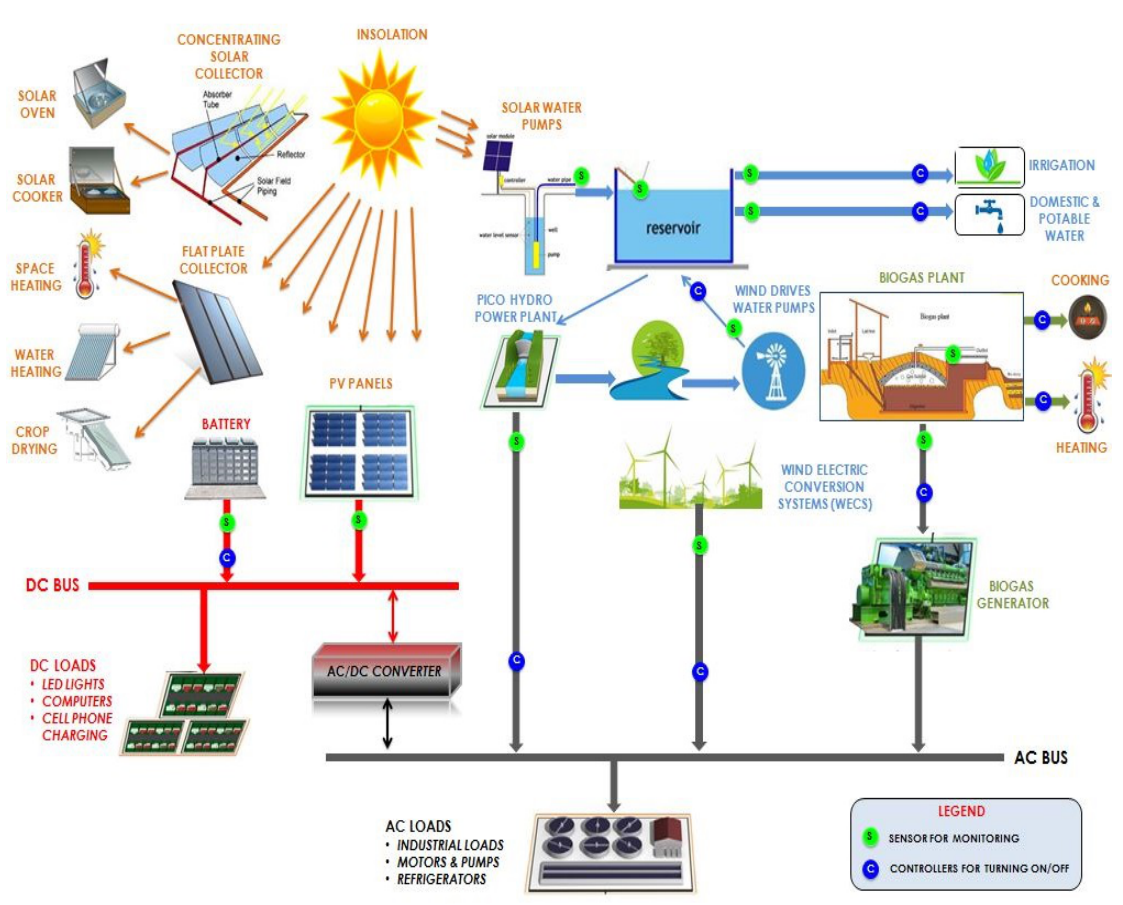
Figure 2. Generic schematic diagram of